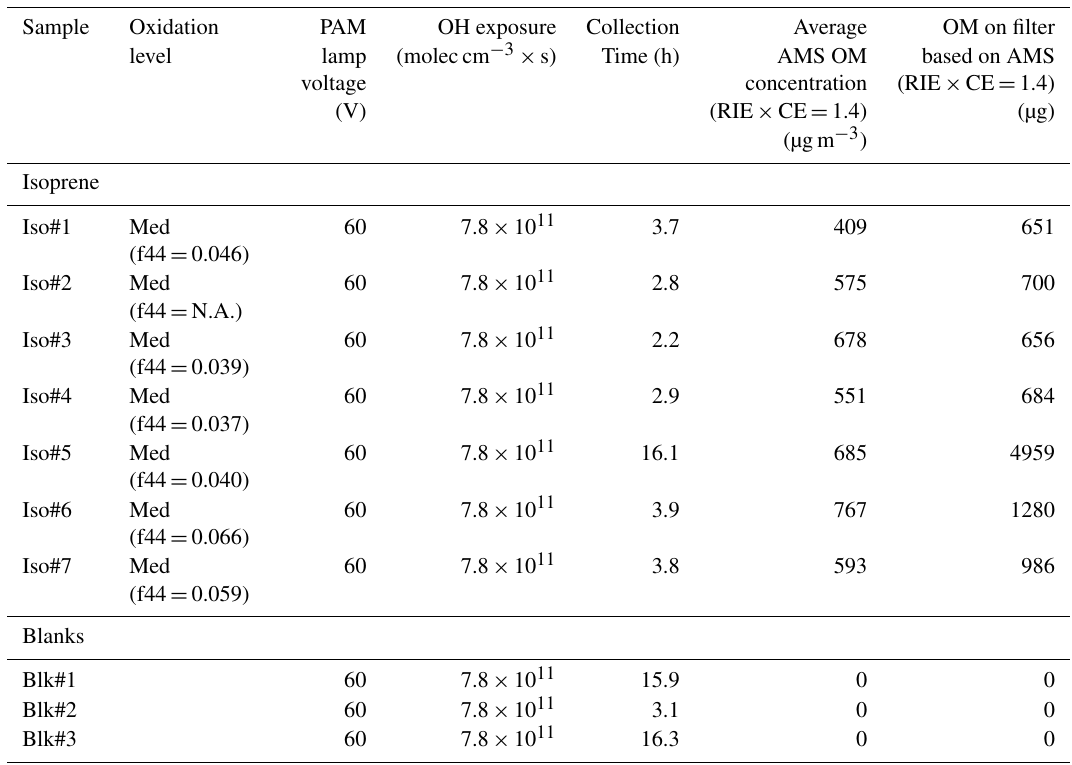
Table 2. PAM experimental conditions for isoprene SOA ageing studies. Sample Oxidation PAM OH exposure Collection Average OM on filter level lamp (moleccm − 3 × s) Time (h) AMS OM based on AMS voltage concentration (RIE × CE = 1.4) (V) (RIE × CE = 1.4) (µg) (µgm − 3